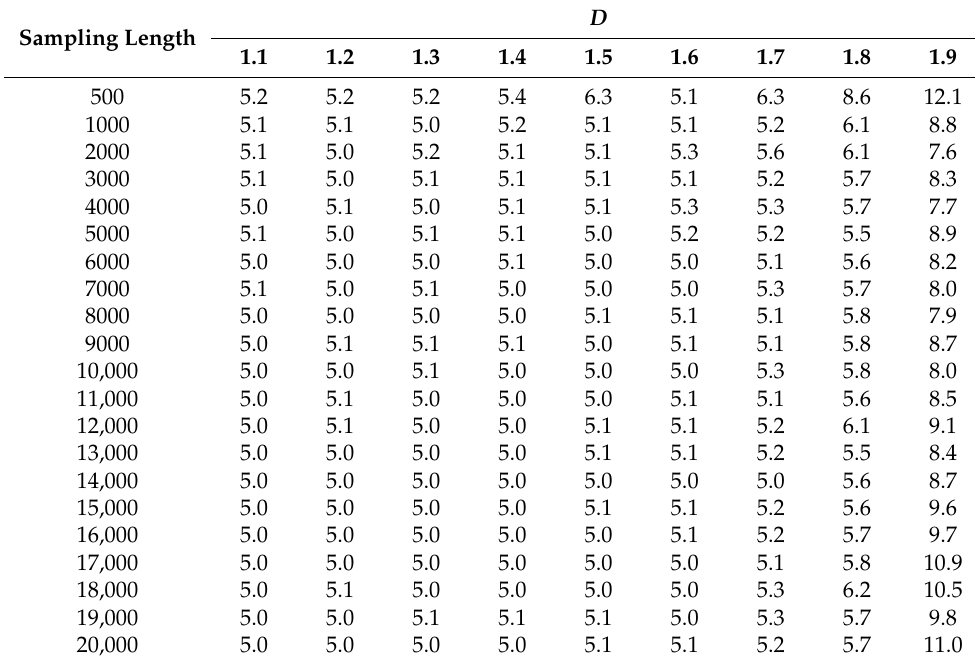
Table A4. Under all sampling lengths and all fractal dimensions, L d of drop points under the condition of 0-order flattening pre-processing.